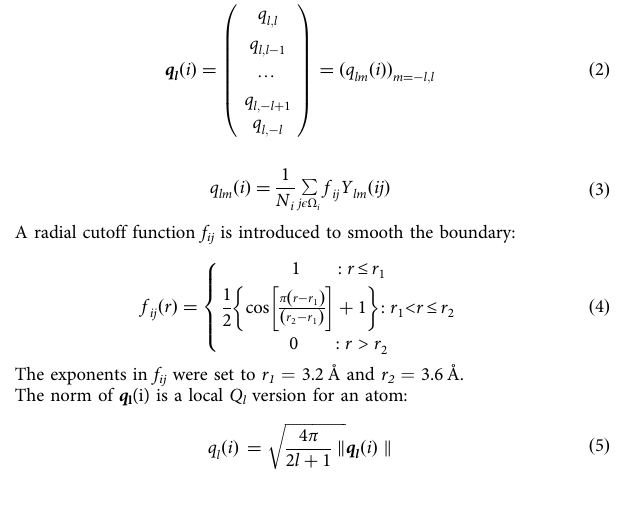
Fig. 4e. Using Hubbard U (4 eV) to correct 4 f electrons locali- Fig. 4e. Both scenarios prove the unstable FS1 structure fi lled